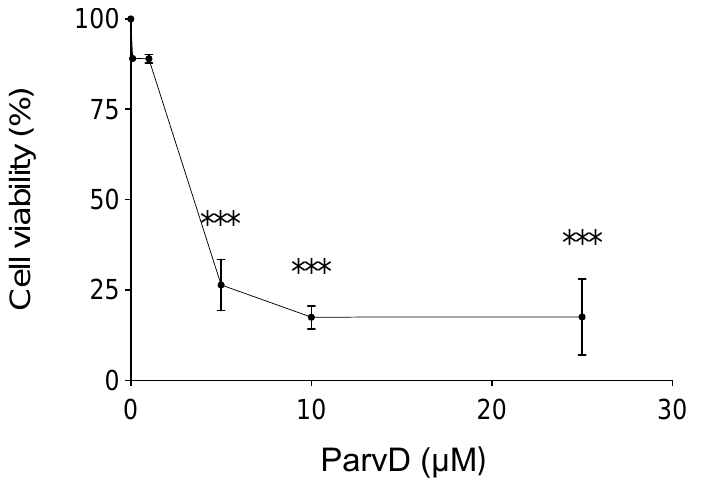
Figure 2. Exposure of cells to ParvD for 48 h reduces MDA-MB-231 cell viability measured by a crystal violet assay. Results are expressed as means ± SD ( n = 2–3). *** p < 0.001 versus control (one-way ANOVA with Tukey’s multiple comparison test).